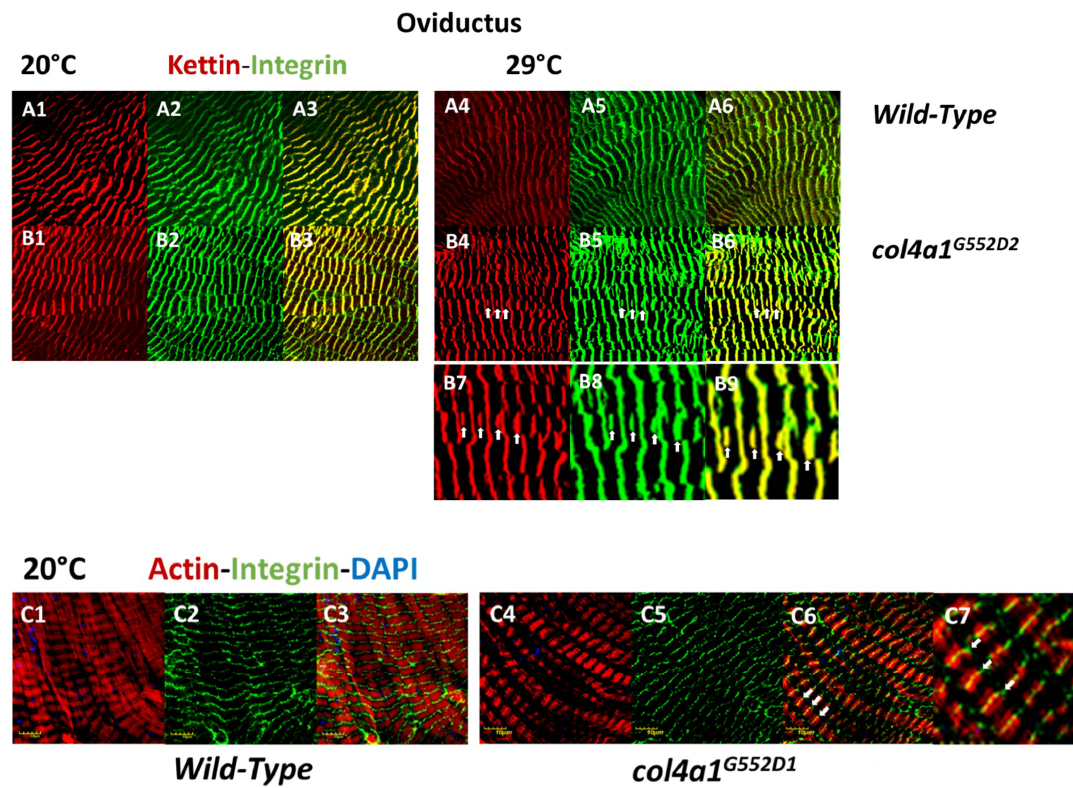
Figure 1. Shifting of Z-discs into the middle of sarcomeres, to the level of M-discs in striated muscle fibers of oviducts. The scaffold protein kettin is deposited at the level of the Z-discs (A1, A4, B1, B4) and overlaps with the integrin label ( A2 , A5 , B2 , B5 ) providing yellow-orange complementary colors in the overlays (A3, A6, B3, B6). Note the irregular integrin expression in the mutant at 29 °C, zig-zag pattern and streaming of Z-discs (B5). Additional kettin-integrin expression appears in the middle of sarcomeres at the level of M-discs (white arrows, B4, B5, B6). Higher magnification of areas in B4, B5 and B6 are marked by arrows (B7, B8, B9). The shifting of the integrin expression toward the middle of the sarcomeres is nearly at full expressivity (C4, C5, C6, white arrows). The area marked by arrows in C6 are at higher magnification (C7). Integrin expression remains at the sides of sarcomeres in Z-discs in the wild-type control ( C1 , C2 , C3 ). Bars, lower left: 10 micrometers. Experiments were carried out as described [24,25,26,28,29].